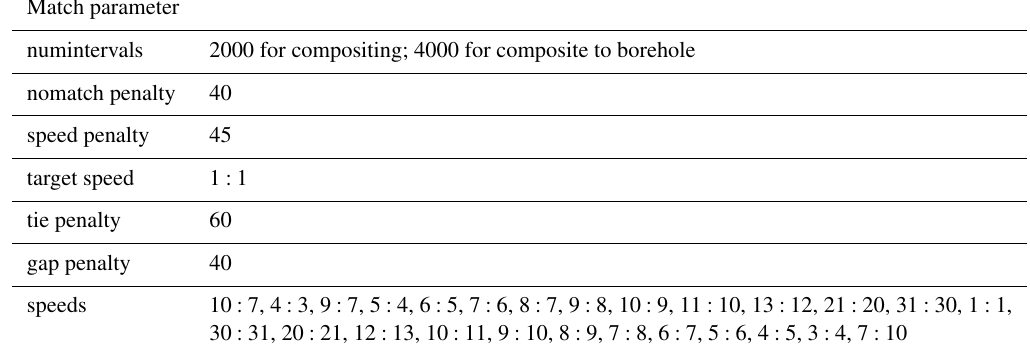
Table 1. Values used with Match algorithm to generate “smooth” mappings of offset holes for new composite sections and for mapping to the borehole conductivity log. The default mapping for the “high-resolution” mapping used speeds of 1 : 3, 2 : 5, 1 : 2, 3 : 5, 2 : 3, 3 : 4, 4 :